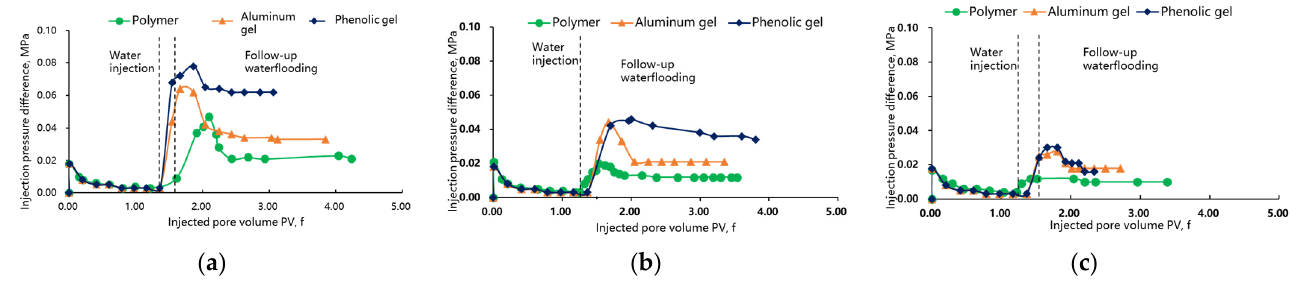
Figure 7. Changes of injection pressure of polymer and gel systems in cores with different permeabilities. ( a ) 0.09–0.45 D; ( b ) 0.95–5.1 D; ( c ) 1.6–8.1 D.